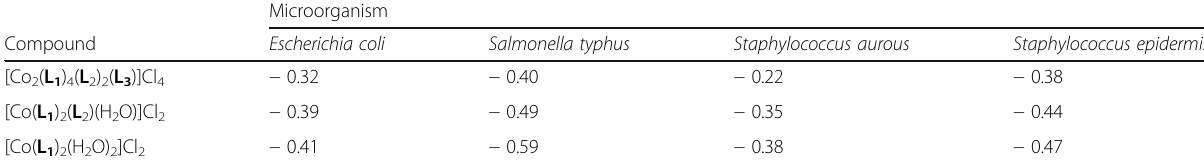
Table 5 The percentage activity index data of the complexes against the tested bacteria compared ciprofloxacin